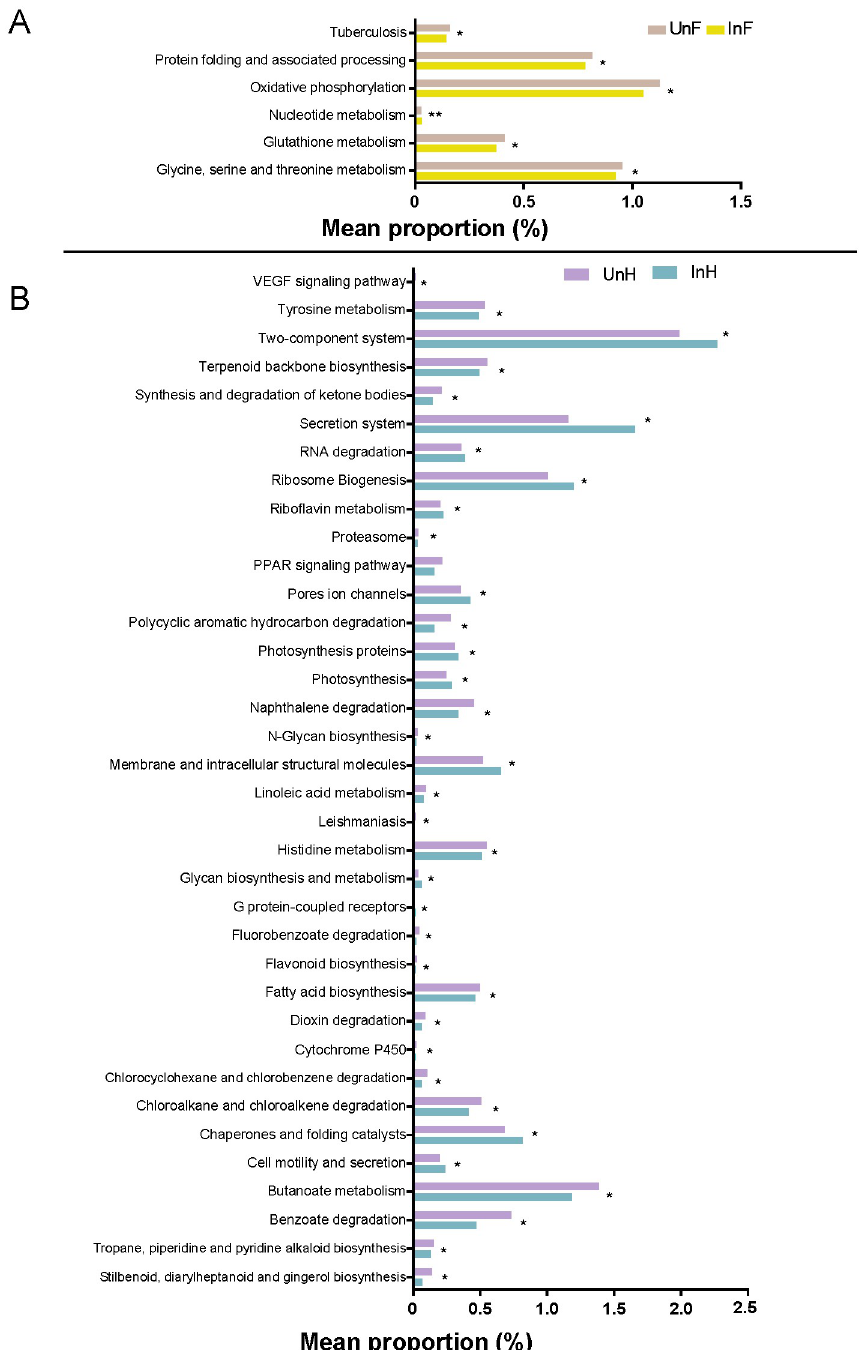
Fig 9. Changes in the KEGG pathways predicted by PICRUST. UnF, uninfected with S . acheilognathi in the foregut of grass carp; UnH, uninfected with S . acheilognathi in the hindgut of grass carp; InF, infected with S . acheilognathi in the foregut of grass carp; InH, infected with S . acheilognathi in the hindgut of grass carp. P -value was calculated using Welch’s t-test for two groups comparison; 0.01 < P < 0.05 values are marked with “ � ” and P < 0.01 values are marked with “ ��